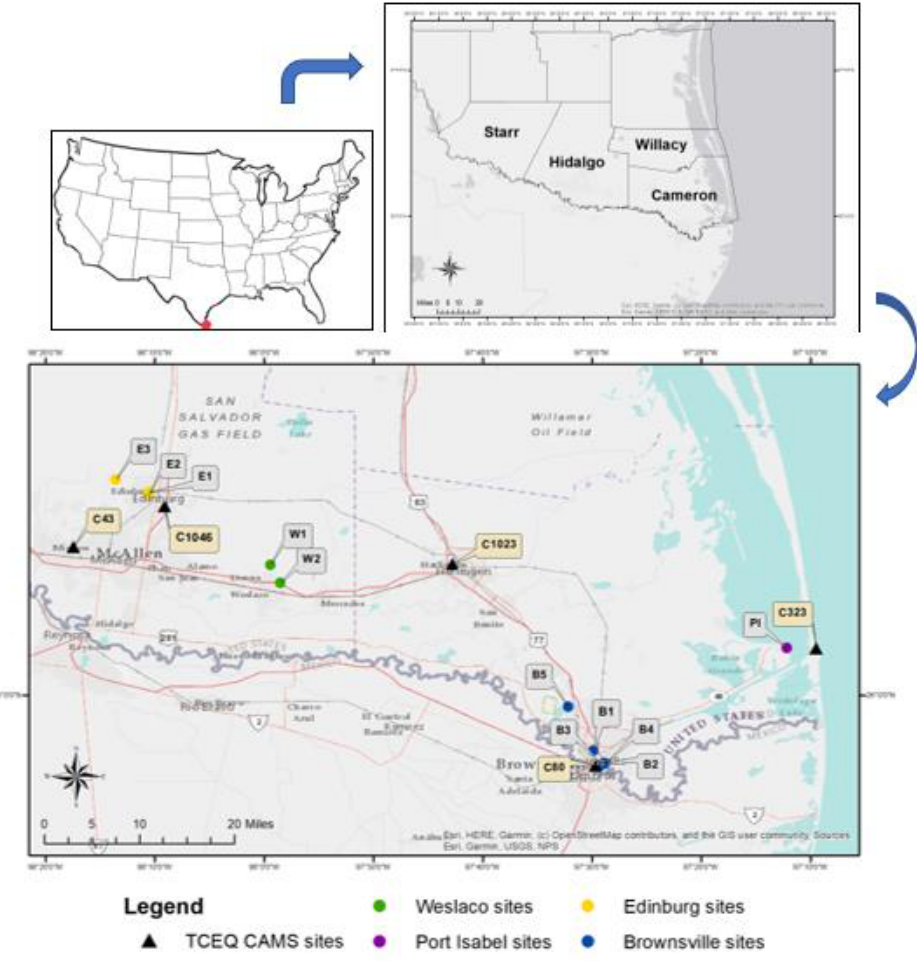
Figure 1. Map of the study location showing the deployed LCSs and TCEQ CAMS sites.